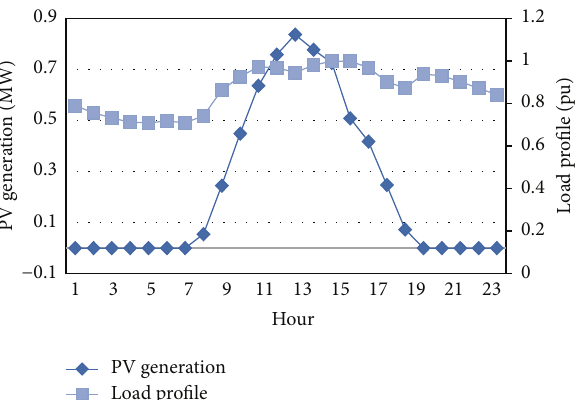
Figure 3: PV generation and load profile of a